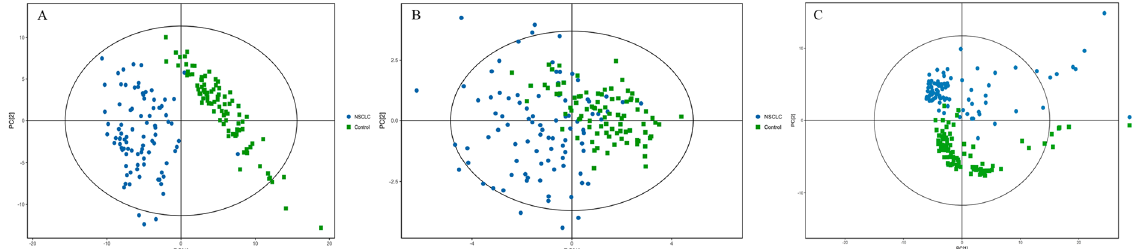
Figure 3. PCA score plots of metabolic profiles in early-stage NSCLC patients and HC with or without mean- centred (ctr) scaling. ( A ) UHPLC-Q-TOF/MS analysis in the positive mode, R 2 X = 0.627. ( B ) UHPLC-Q-TOF/ MS analysis in the negative mode, R 2 X = 0.529. ( C ) GC-TOF/MS analysis, R 2 X = 0.416. Dots and boxes denote samples from early-stage NSCLC patient and HC, respectively.